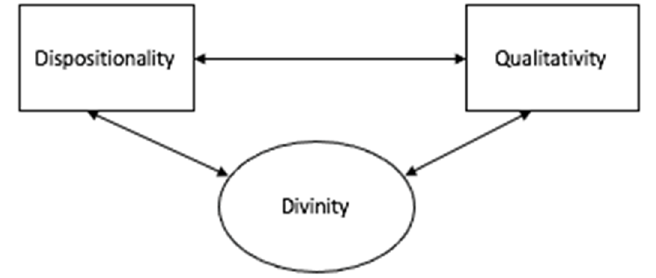
Figure 4. Theistic Powerful Trope.